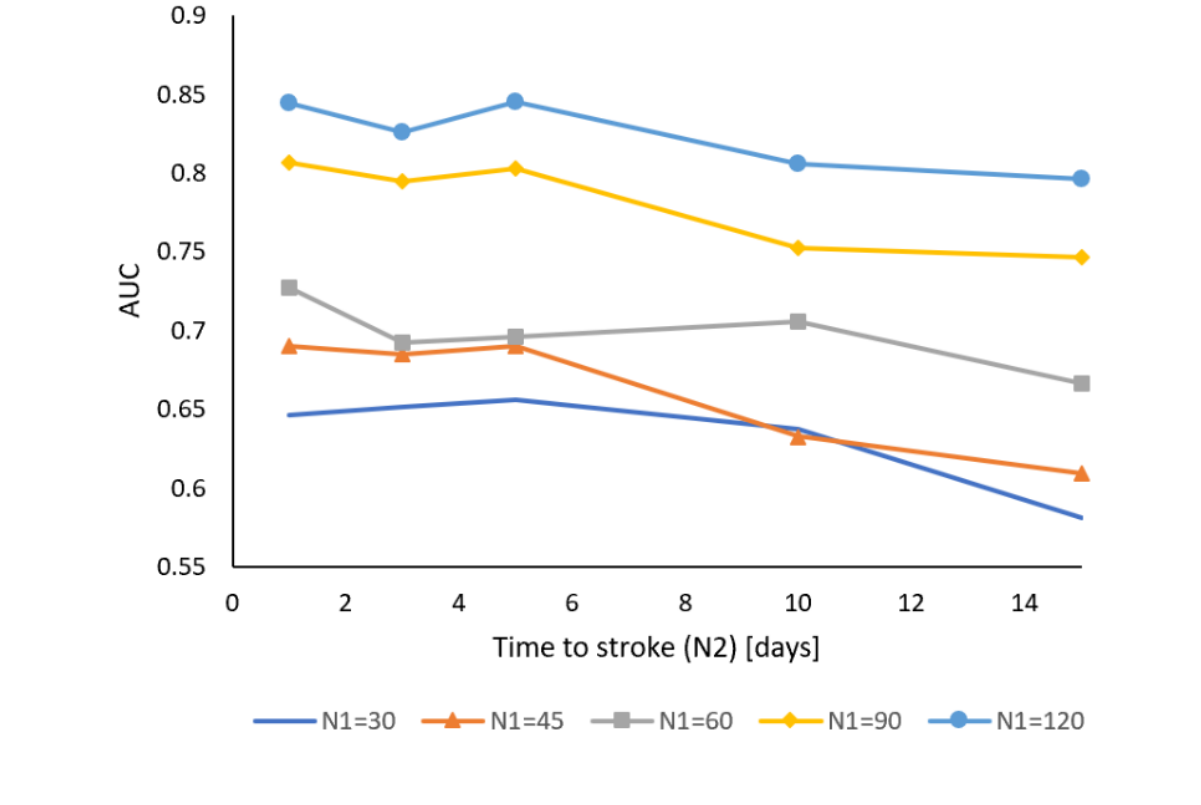
Figure 4. Area under the receiver operating characteristic curve (AUC) as a function of N_2, the number of days ahead for which the prediction is made. Different curves show different values of N_1, the time prior to stroke that is taken as nonstroke